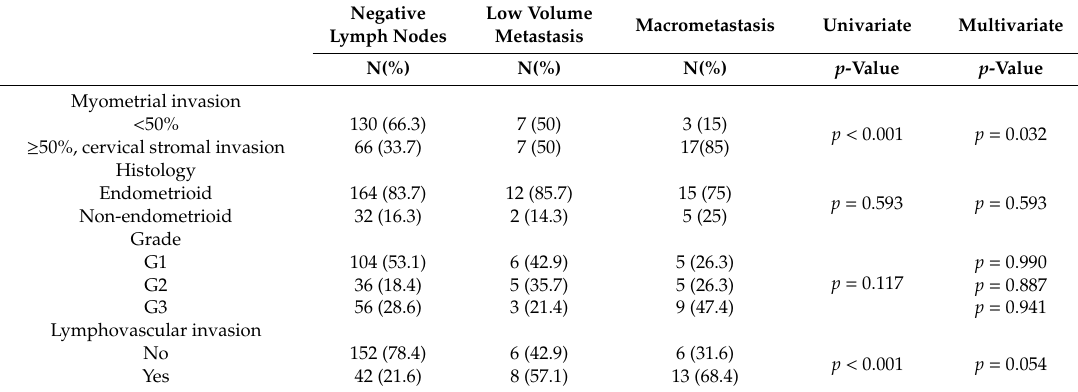
Table 2. Comparison of uterine histopathological risk factors by nodal metastasis size. Univariate and multivariate analyses.